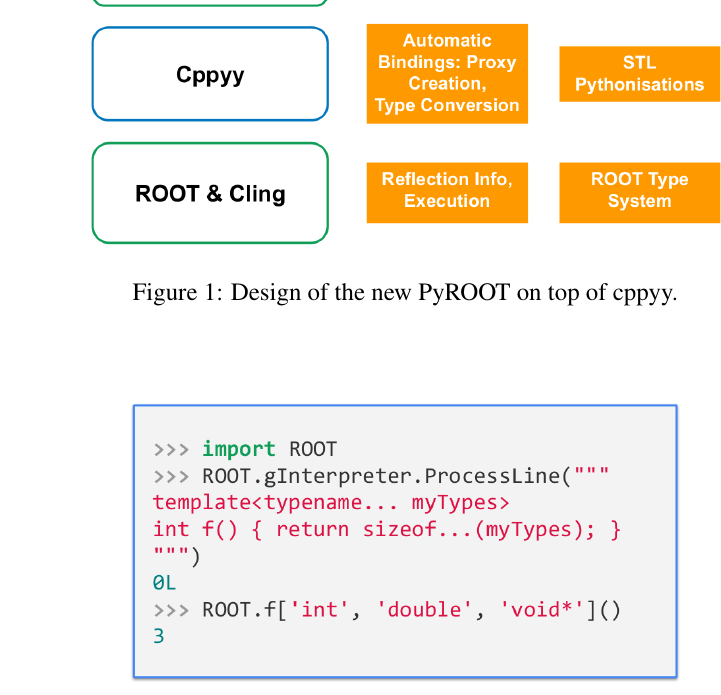
Figure 2: This example dynamically defines a C ++ function template with variadic tem- plate syntax via PyROOT; after that it instantiates the template with three types and calls the resulting